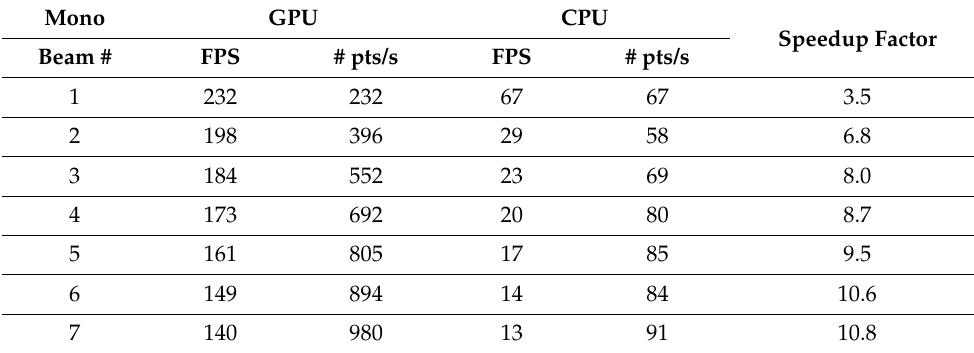
Table 1. CGH processing time for single-beam steering using a CPU and a GPU in the monochro- matic mode (Beam # refers to number of beams; # pts/s refers to the number of points are steered per second).